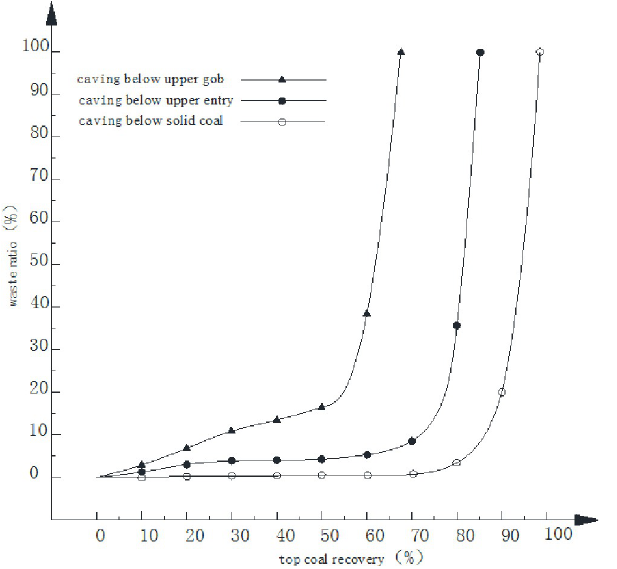
Fig 8. Relationship between the waste ratio and coal recovery.